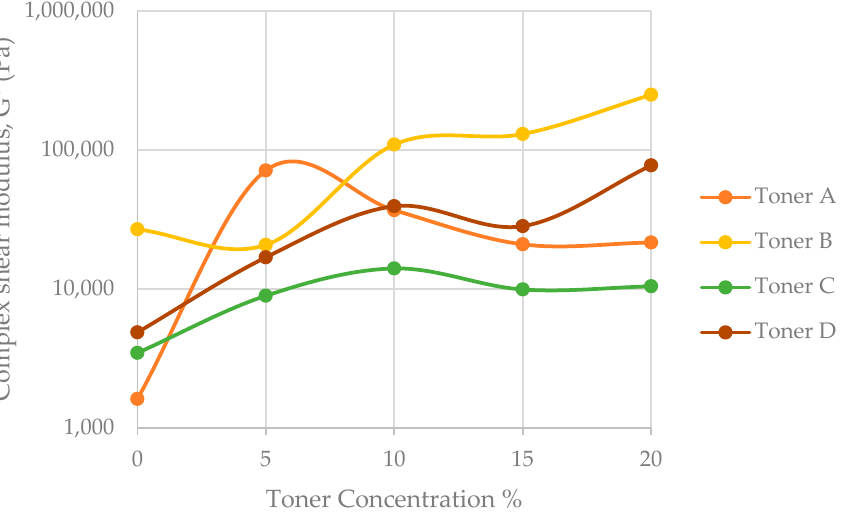
Figure 4. The influence of % toner concentration on complex shear modulus (G*) for waste toners A, B, C, and D, measured at 1.59 Hz and 60 ◦